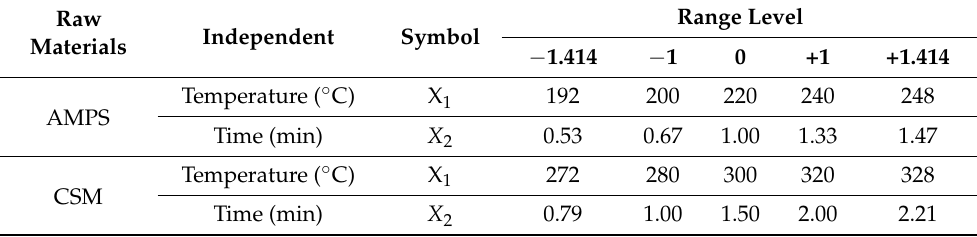
Table 5. Symbol, experimental range and values of the independent variables in the central composite design.